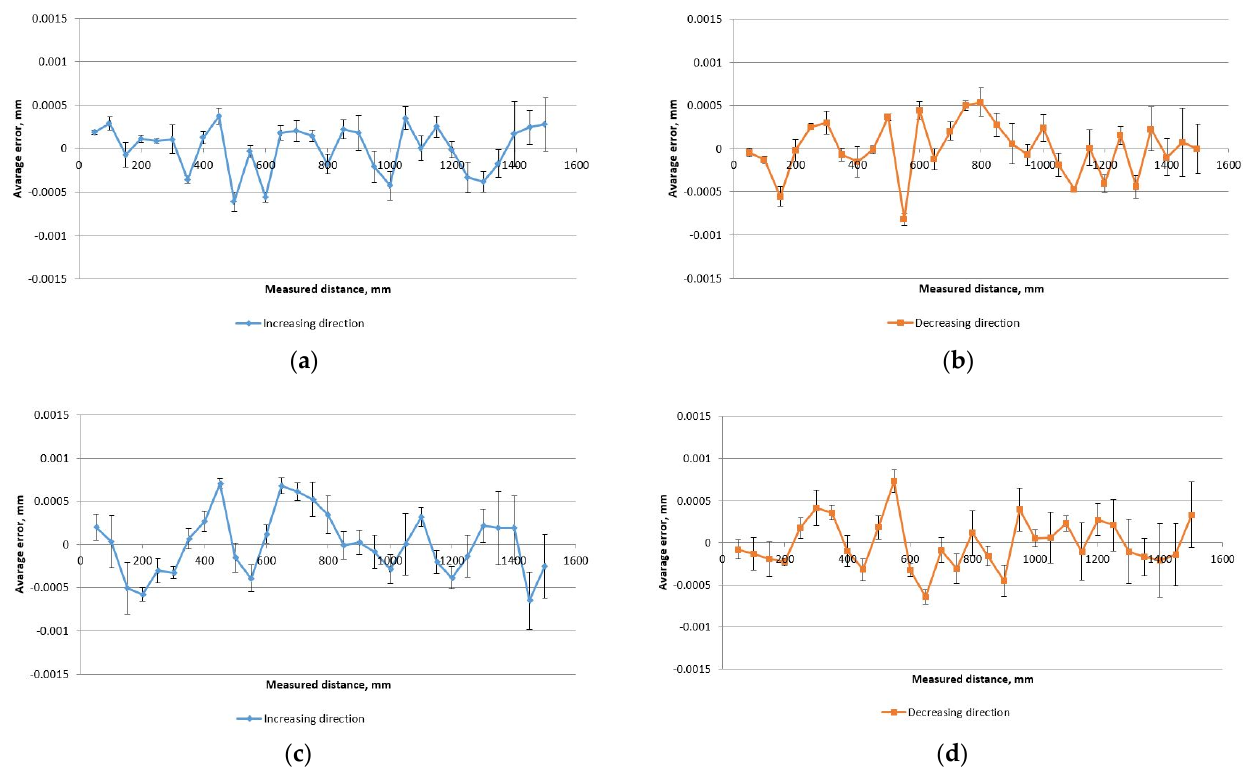
Figure 3. Averaged error values during measurement: ( a ) increasing direction, inactive motors; ( b ) decreasing direction, inactive motors; ( c ) increasing direction, active motors; ( d ) decreasing direction, active motors. Error bars show the standard deviation value.